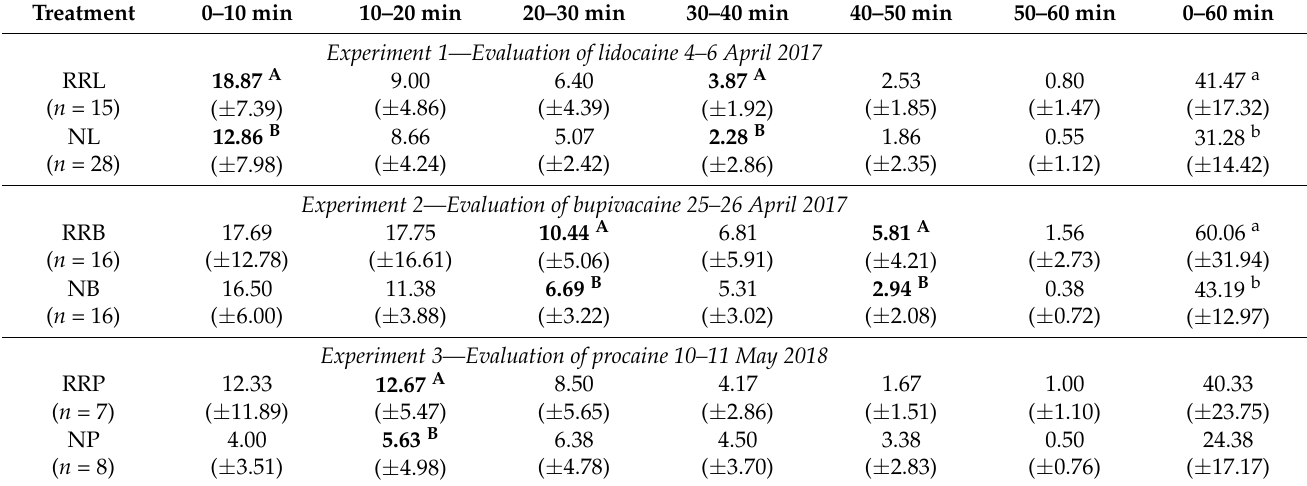
Table 5. Mean ( ± standard deviation) count of restlessness expressed by male lambs. Within each experiment, means within a column with differing uppercase superscripts (A, B) differ significantly ( p < 0.05), while differing lowercase superscripts (a, b) indicate a tendency to differ (0.1 > p > 0.05). RRL ring only, no local anesthetic; NL ring applied with lidocaine administered using the Numnuts ® tool; RRB ring only, no local anesthetic; NB ring applied with bupivacaine administered using the Numnuts ® tool; RRP ring only, no local anesthetic; NP ring applied with procaine administered using the Numnuts ® tool.